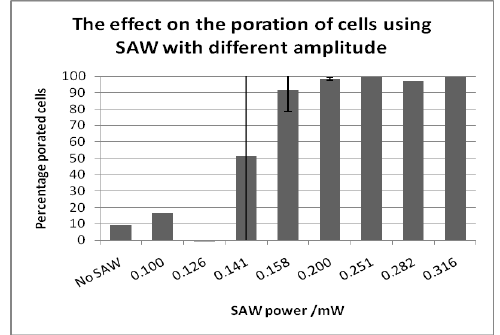
FIGURE 2: SAW poration of KCL-22 cell membranes at different powers. In this preliminary experiment, the error bars represent 1 standard deviation from the